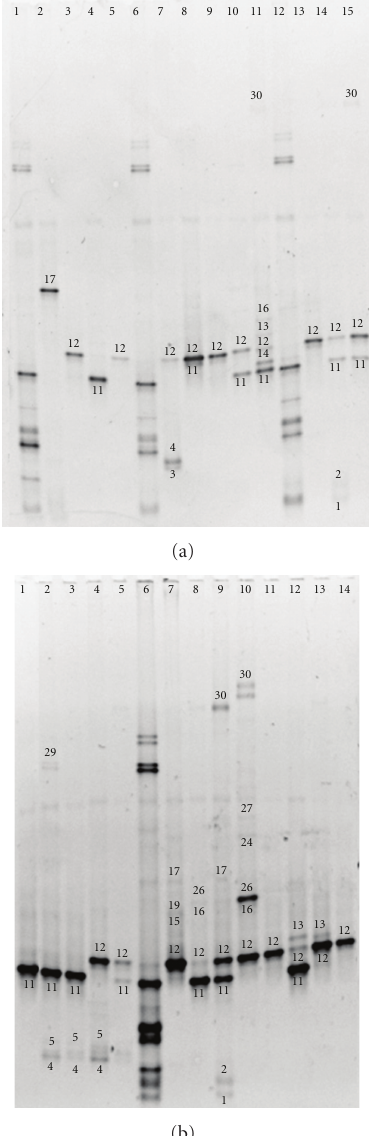
Figure 3: Denaturing gradient gel electrophoresis of vaginal samples from third trimester. Gel A ( n = 13); lines 1–5 and 7– 14 samples. Line 6 internal DNA lab standard. Gel B ( n = 10); lines 1–10 samples. Number of DNA band in the figure related to Table 2, where the percentage of identification in women studied and GenBank access number data identification are